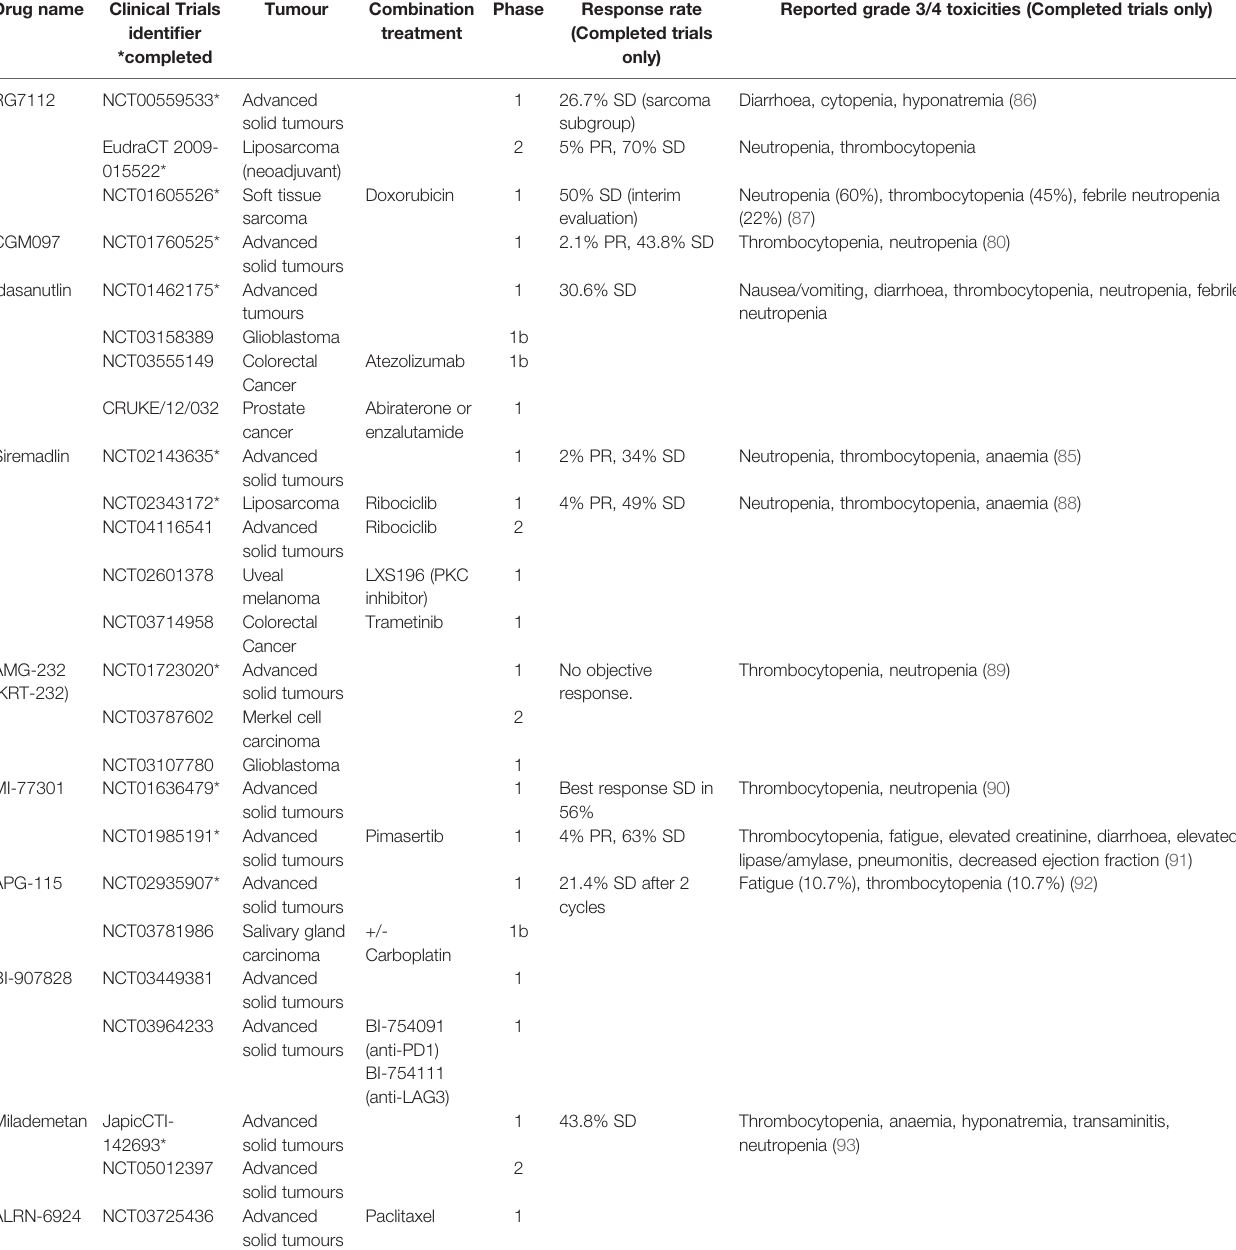
TABLE 1 | MDM2 inhibitors in clinical